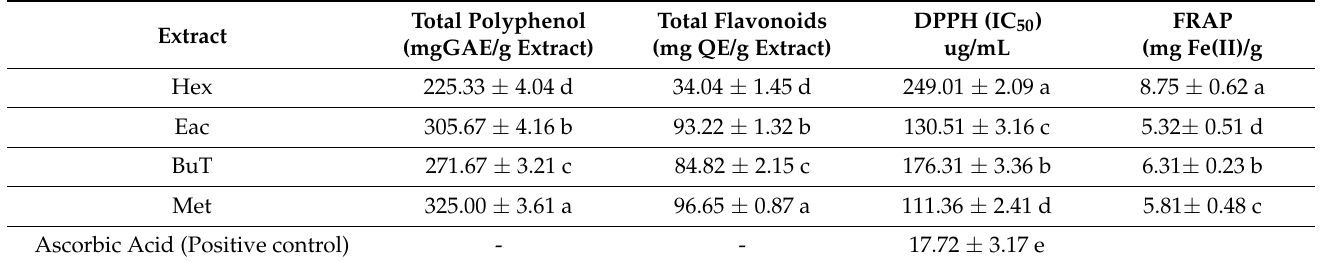
Table 1. TFC (flavonoid contents), TP (total phenolics), DPPH (2,2-diphenyl-1-picryl-hydrazyl) IC 50 ,